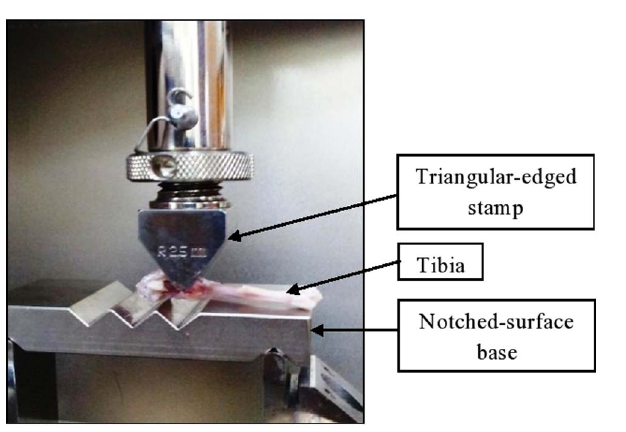
Fig. 2. Extraction of mineralized callus from total callus area. a) Contour line was made to set for total callus area; b) Extraction of mineralized callus by applying threshold of 421 mgHA/cm 3 . Higher mineralized callus volume extracted from the total callus area showed better improvement in fracture healing.